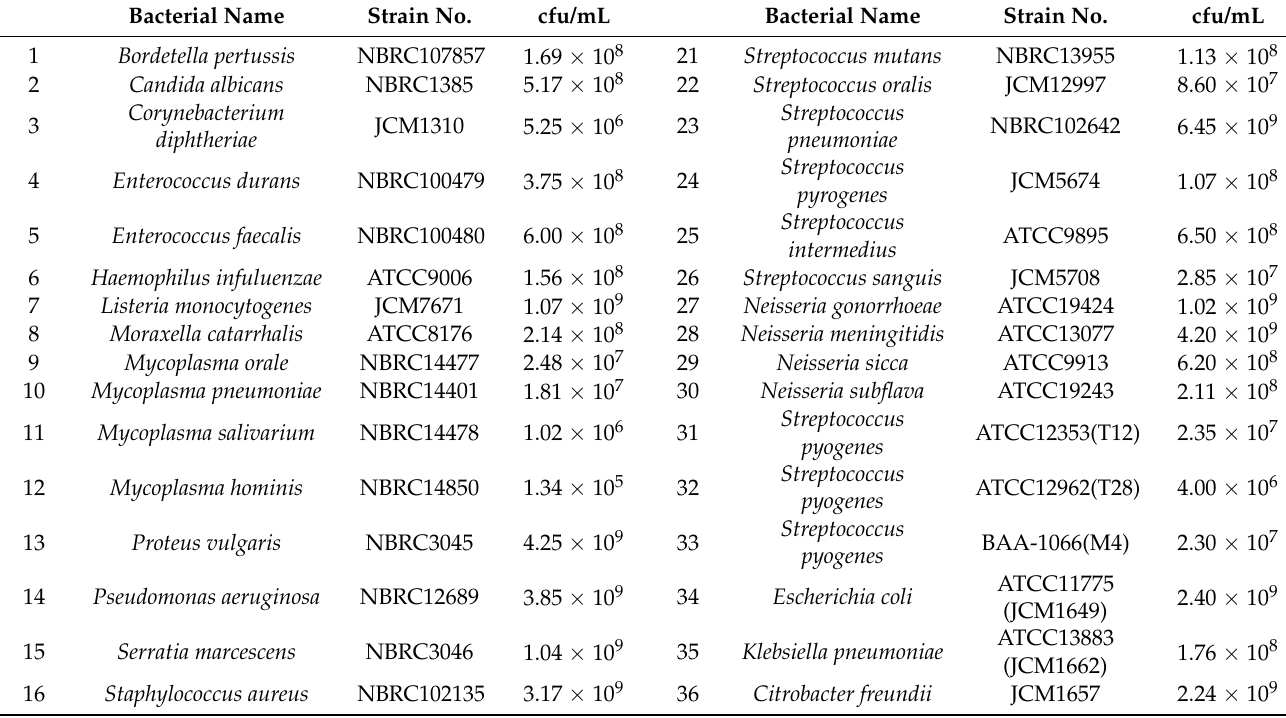
Table 2. Oral bacteria using crossover examination of ADCHECK.